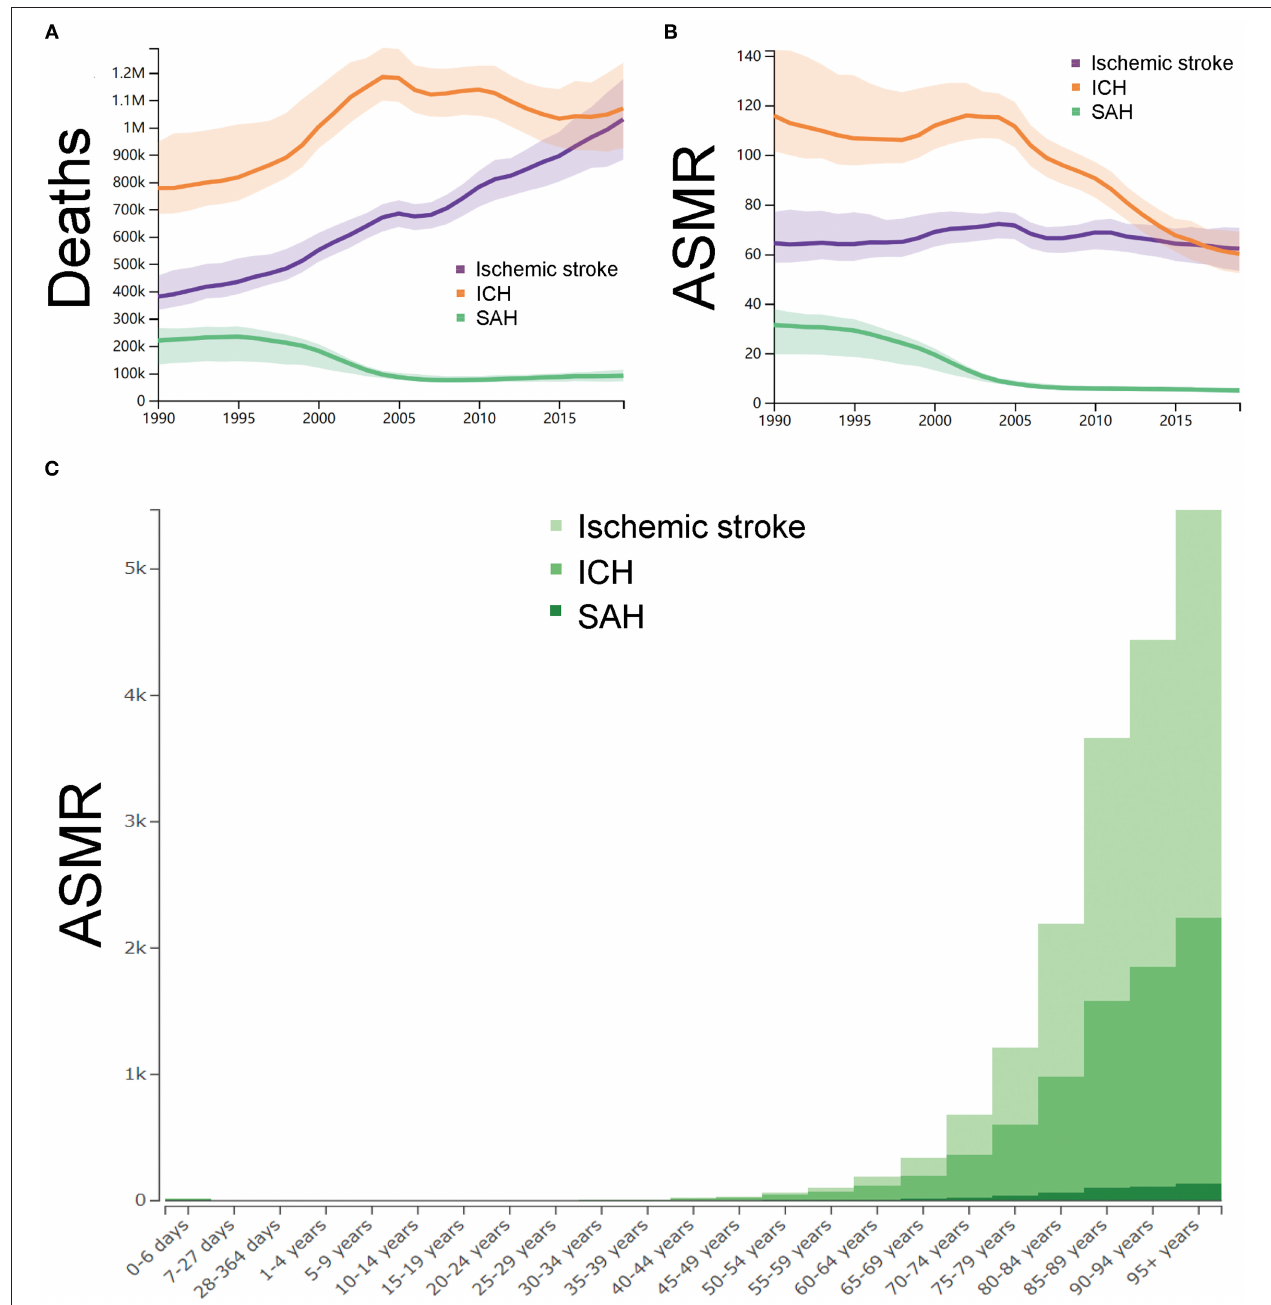
FIGURE 3 | The trends in mortality of strokes. (A) Number of deaths with uncertainty from 1990 to 2019 in China. (B) Age-standardized mortality rate per 100,000 with uncertainty from 1990 to 2019 in China. (C) The age-standardized mortality rates per 100,000 of different age groups. ASMR, age-standardized mortality rate ICH, intracerebral hemorrhage; and SAH, subarachnoid hemorrhage. The figures were generated through GBD Results Tool and GBD Compare